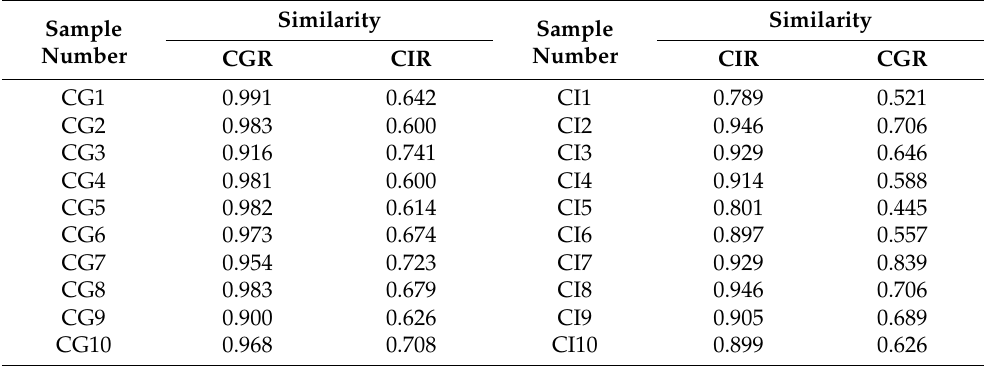
Table 1. Results of similarity evaluation of HPLC fingerprint between Cichorium glandulosum Boiss et. Huet and Cichorium intybus